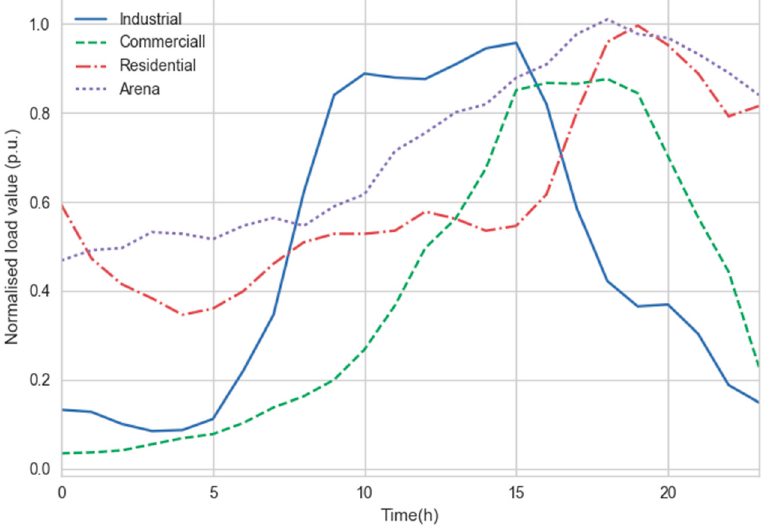
Figure 3. Normalised load profiles used for the other loads in the ArenA network in the simulation studies.